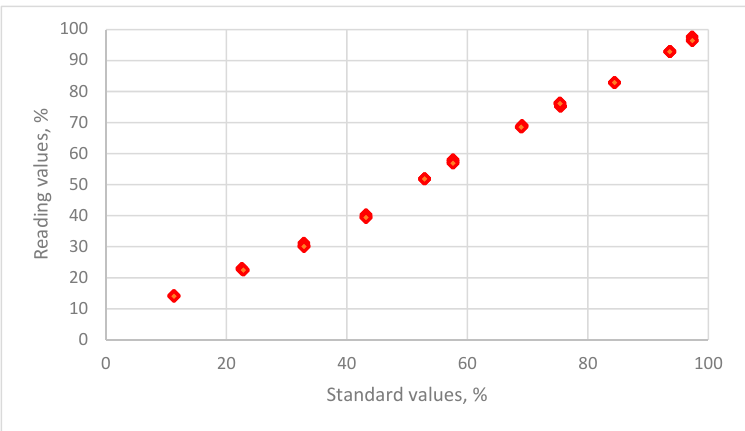
Figure 2. The distribution of the relative humidity data for reading values versus the standard humidity values for THT-B121 resistive humidity sensor using 11 saturated salt solutions (LiCl, CH 3 COOK, MgCl 2 , K 2 CO 3 , Mg(NO 3 ) 2 , NaBr, KI, NaCl, KCl, KNO 3 and K 2 SO 4